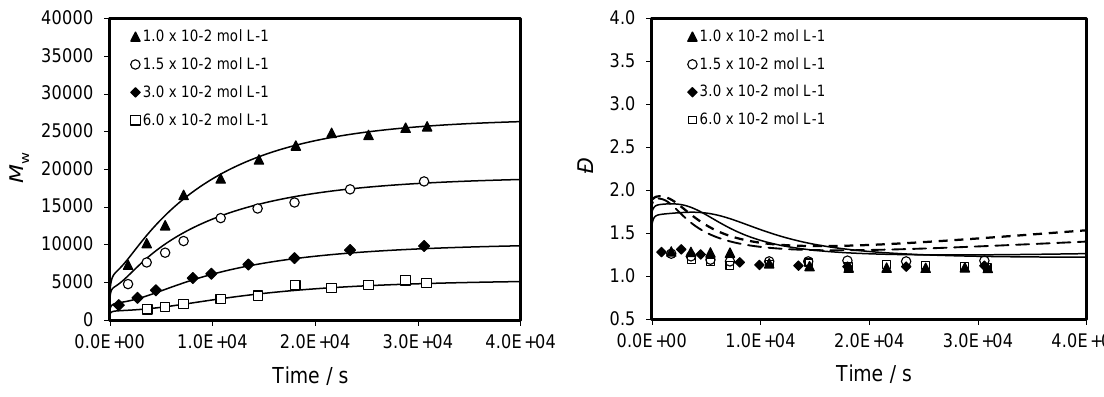
Figure 6. Evolution of M w and Đ versus reaction time for CPDB-mediated polymerization of TBDMSMA in toluene at 70 °C with initial concentration of CPDB ranging from 1.5 × 10 −2 to 6.0 × 10 −2 mol·L −1 . The graph compares predicted values (lines) with experimental data (points).